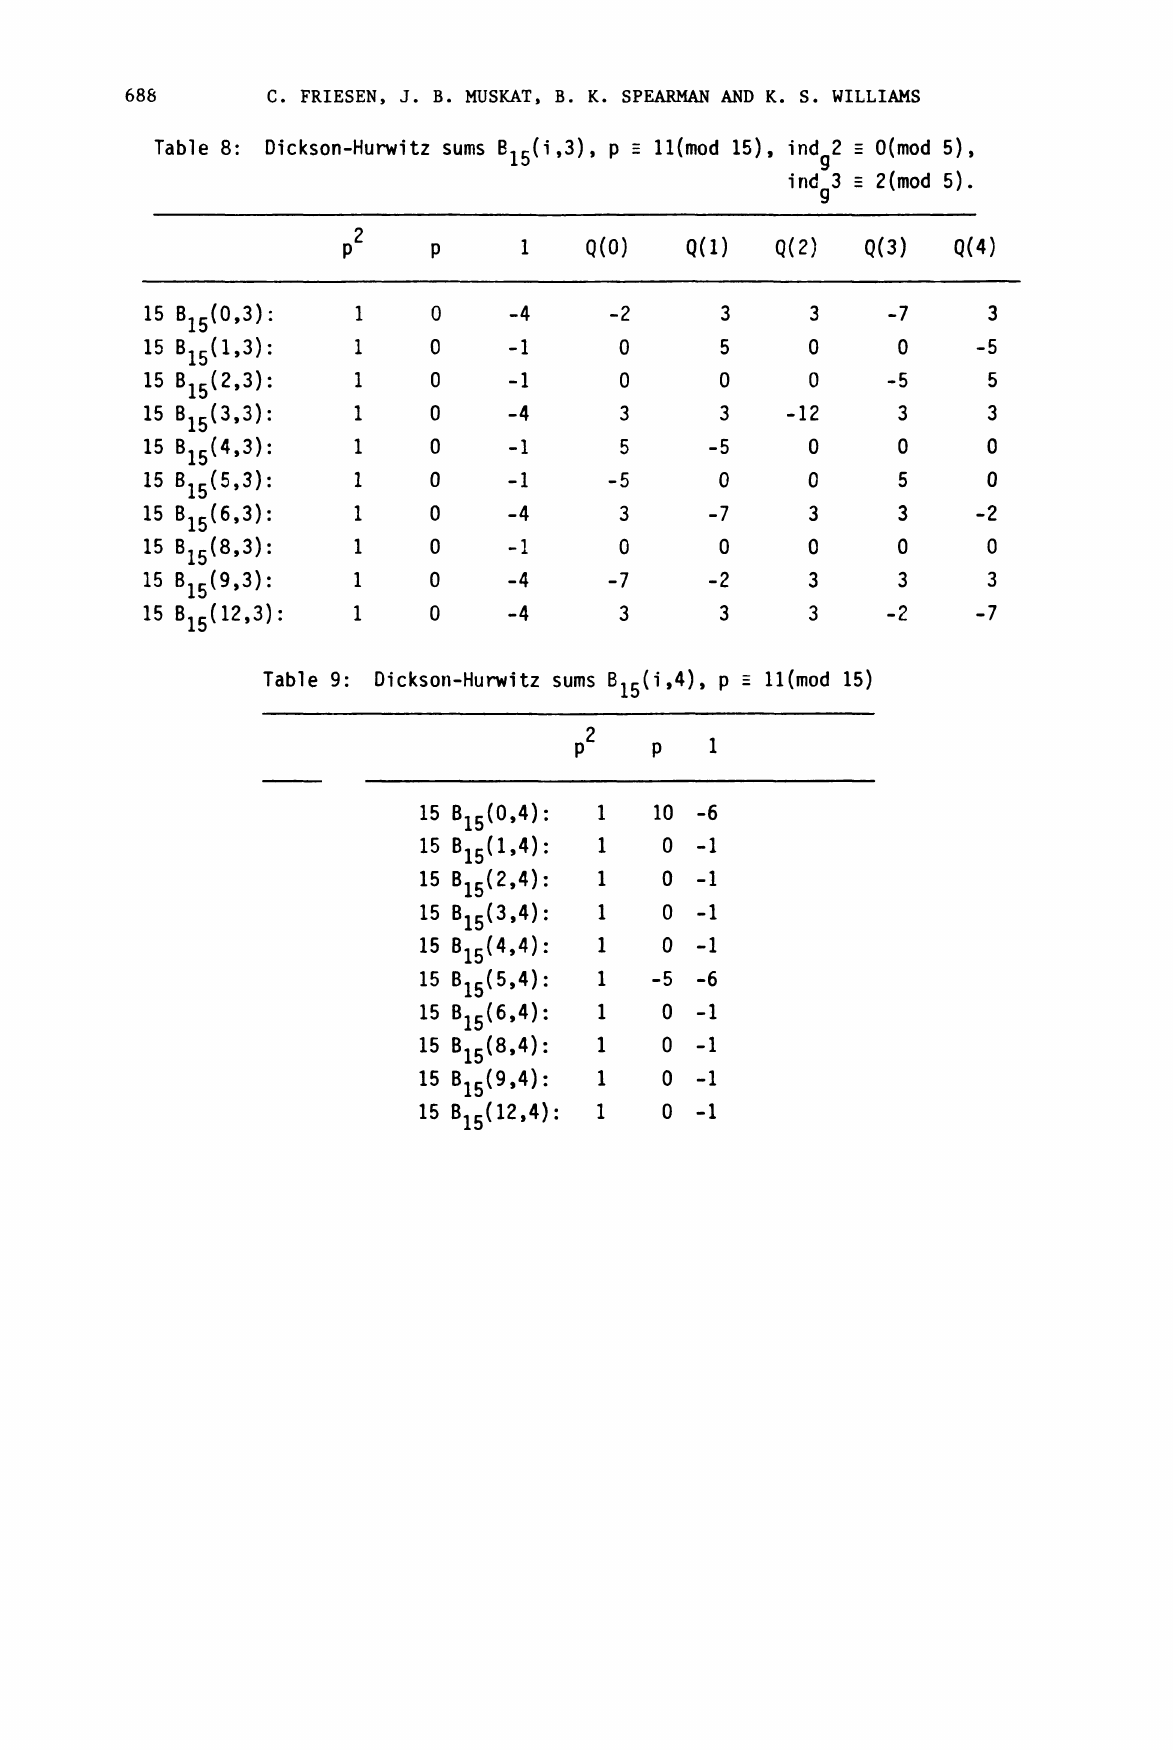
Dicksor1-Hurwitz sums B15(i,4),